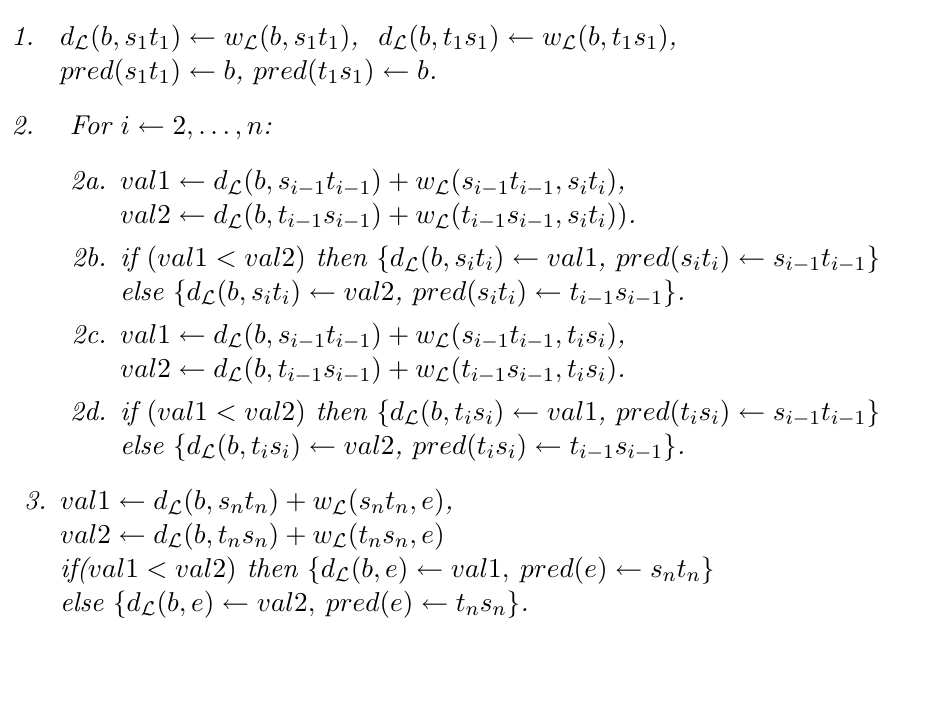
Algorithm 1 (Shortest path through the layered graph L